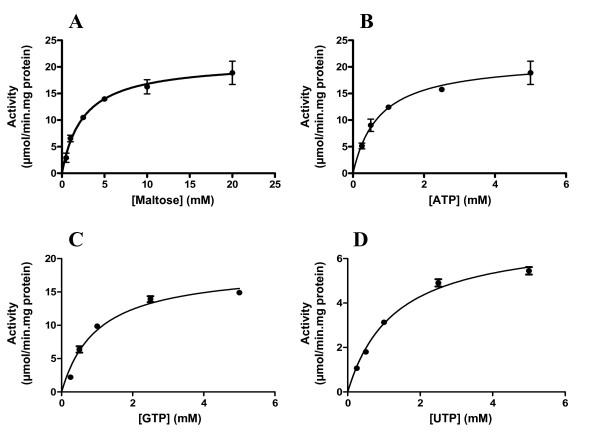
Kinetic studies of Mak activity. Dependence of Mak activity on the concentrations of maltose (A), ATP (B), GTP (C) and UTP (D).